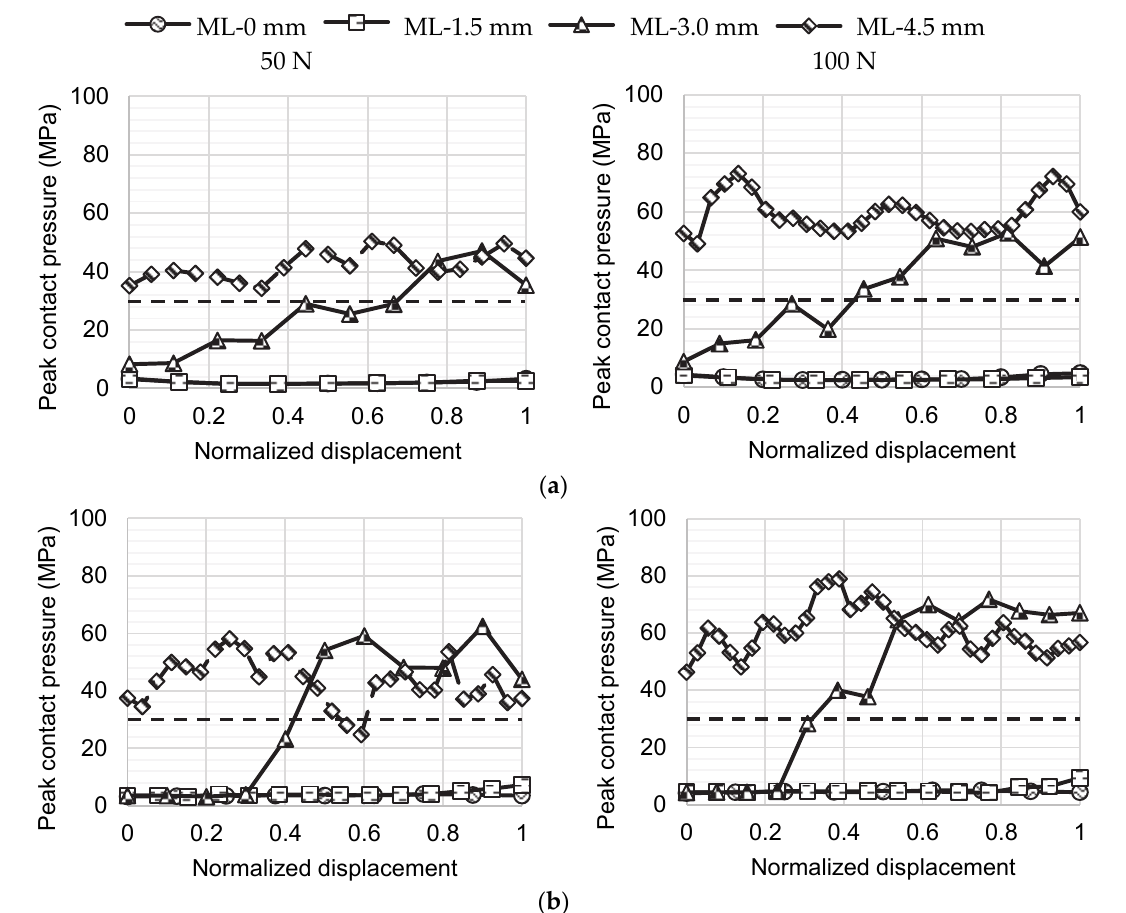
Figure 5. Stability ratios of the glenohumeral joint with a 20% glenoid bone defect after the Latarjet procedure for the medial–lateral graft positions modeled: ( a ) shoulder in 0° abduction in the scapu ‐ lar plane and in neutral rotation, and ( b ) shoulder in 60° abduction in the scapular plane with 45° of external rotation.